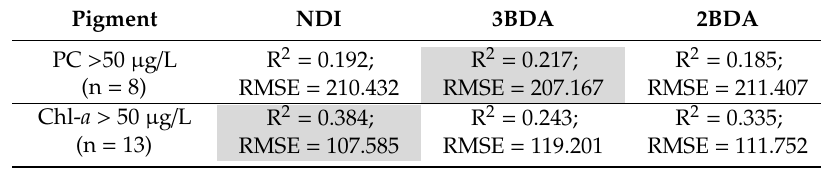
Table 5. Statistical estimators for each algorithm for chl- a and PC estimation. Pigment